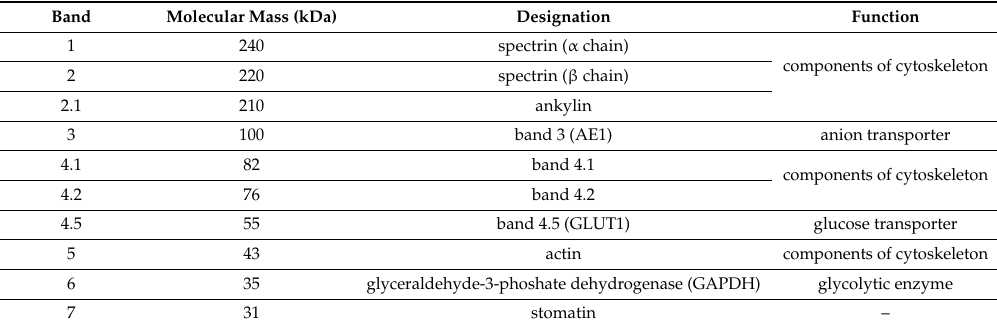
Figure 1. Sodium dodecyl sulfate (SDS)-polyacrylamide gel electrophoresis of human red blood cell (RBC) membranes. Healthy human RBC membranes stained with Coomassie brilliant blue. Electrophoresis was performed according to the method of Laemmli [2]. Table 1. Red blood cell membrane proteins.